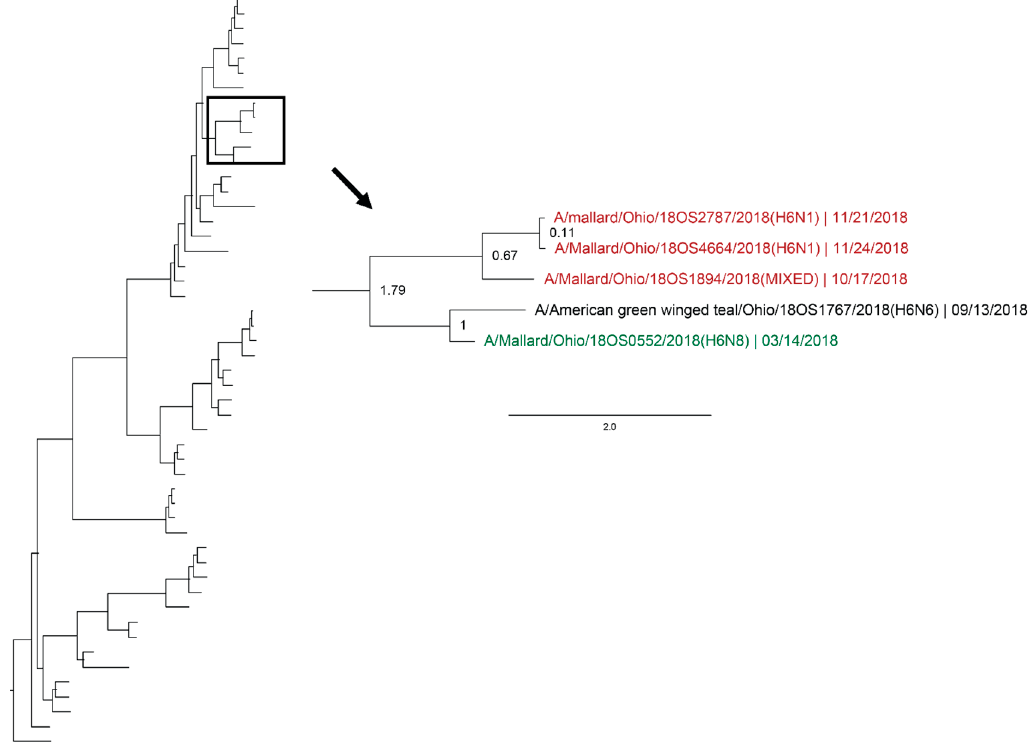
Figure 7. Maximum clade credibility tree of the H6 gene segment. Year-round, active influenza A virus surveillance was conducted in wild mallards ( Anas platyrhynchos ) in one location over two years. Time-stamped phylogenetic analysis with a general time reversible plus gamma substitution model revealed genetic persistence across multiple seasons, including the historically under-sampled spring season, in the HA segment. Highly supported clades ( > 0.95 posterior probability) containing viruses detected in the spring (green) who share a common ancestor with viruses detected in another season (red) throughout the study period with a time to most recent common ancestor of < 2.5 years are highlighted. Node ages are indicated. Scale bar represents time in years.